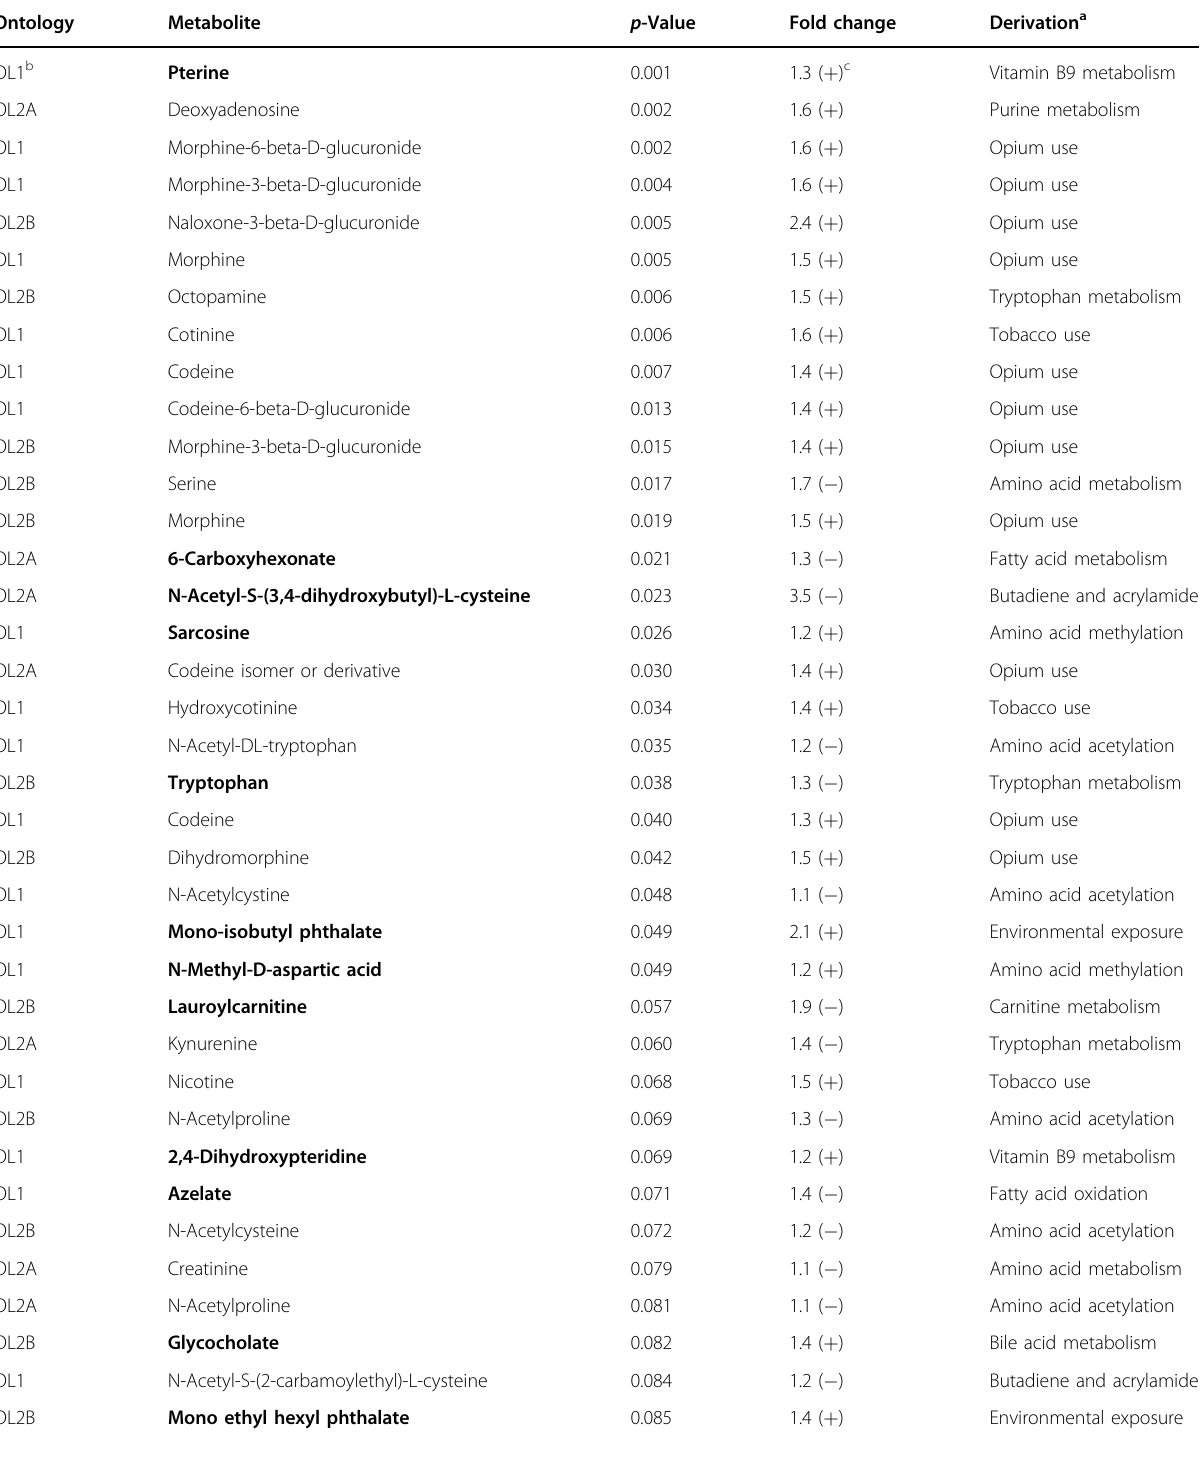
Table 2 Signals that differentiated ( p < 0.10) high OUD positive opium users from high OUD negative opium users (Fig. 1) matched to 40 metabolites in the in-house physical standards